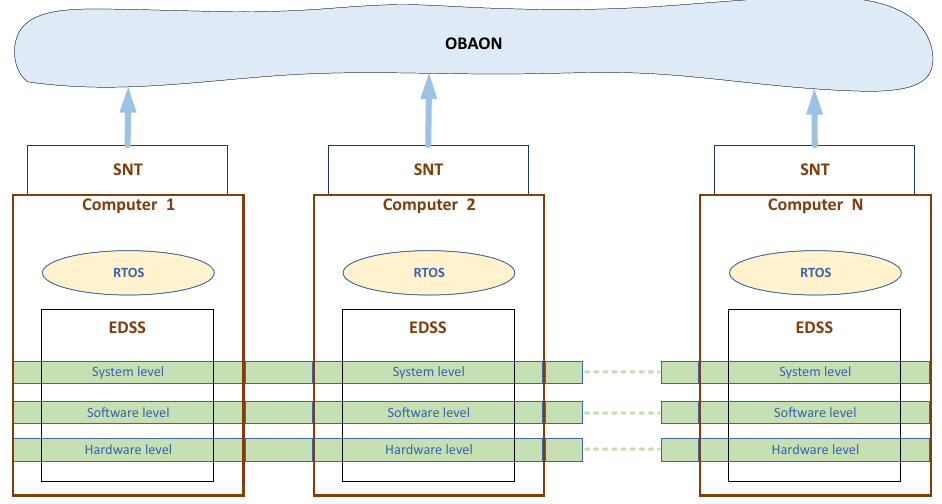
Figure 6. Implementation of the EDSS.